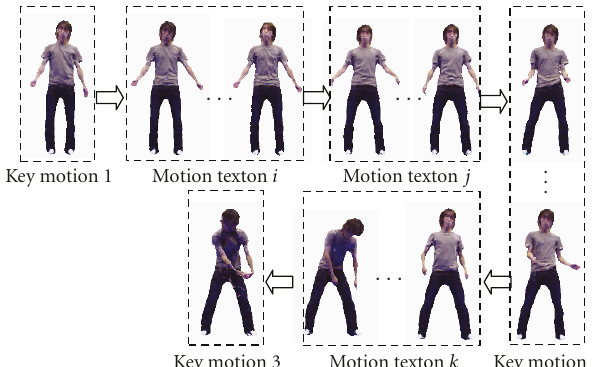
Figure 8: Three key motions in a case study, each row shows a key motion.